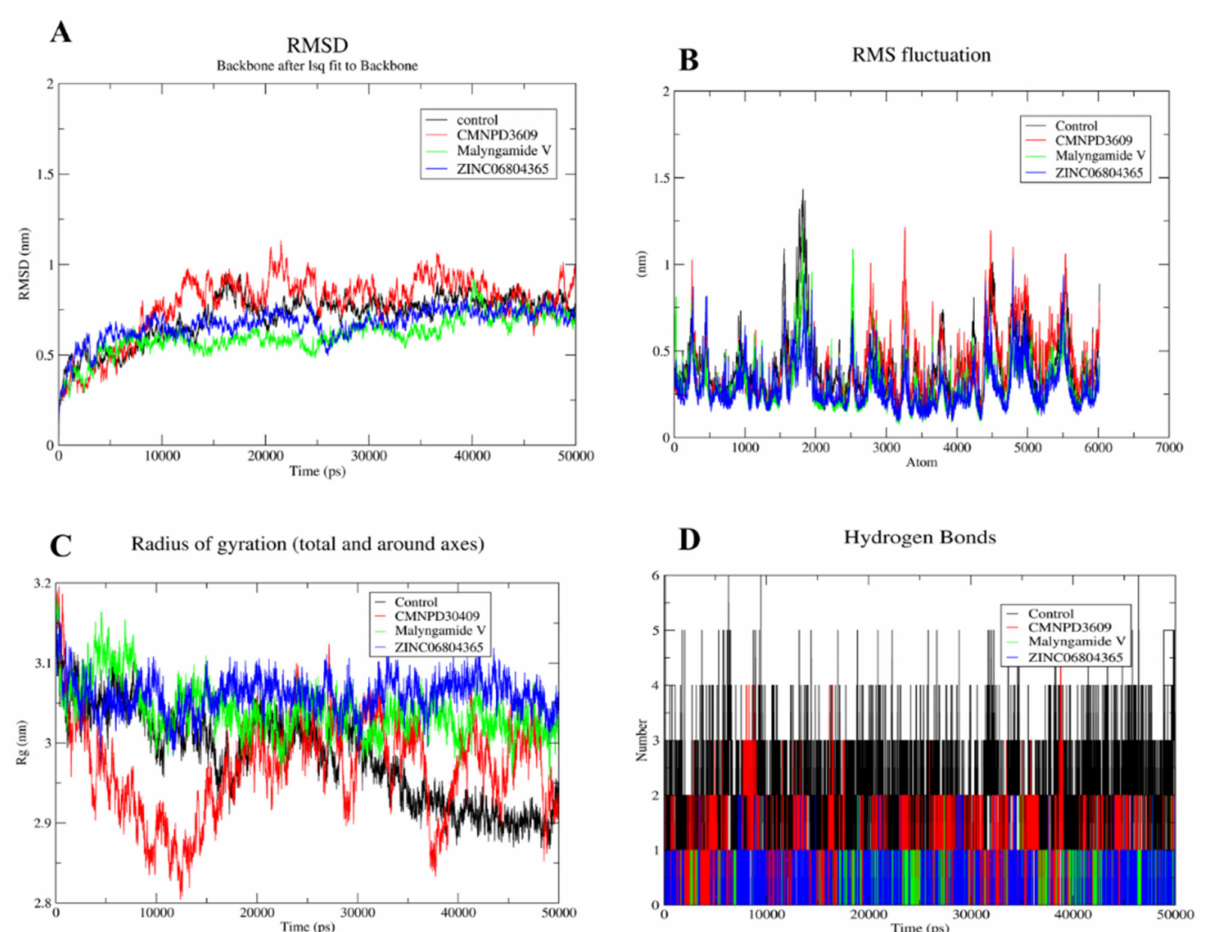
Figure 6. MD simulation for shortlisted compounds, depicting ( A ) RMSD ( B ) RMSF ( C ) Radius of gyration and ( D ) Hydrogen